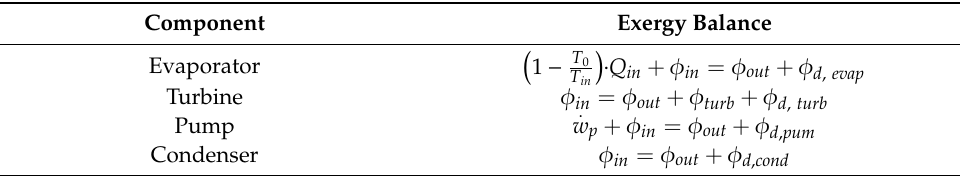
Table 1. Exergy balance applied to each